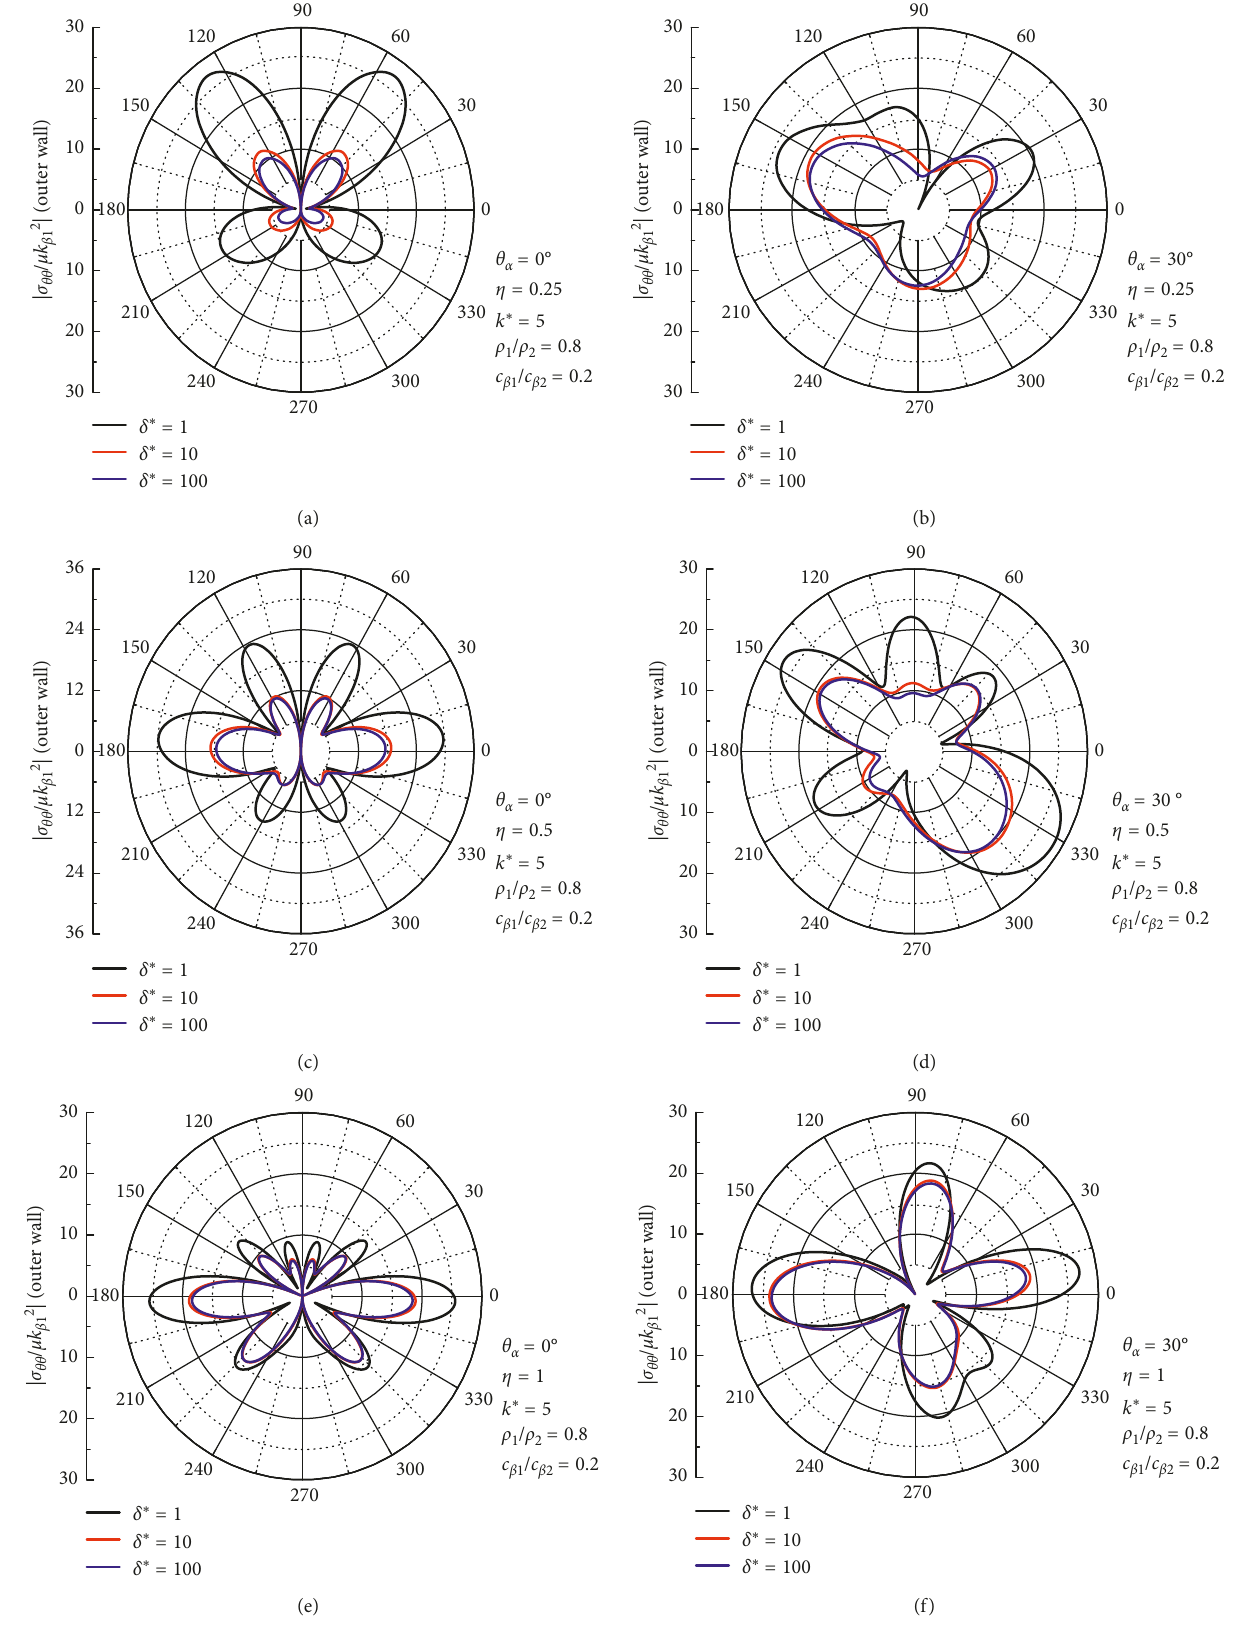
Figure 7: DSCF distribution on outer lining wall surfaces under incident SV waves: (a) η θ α 0 ° ; (d) η (cid:29)